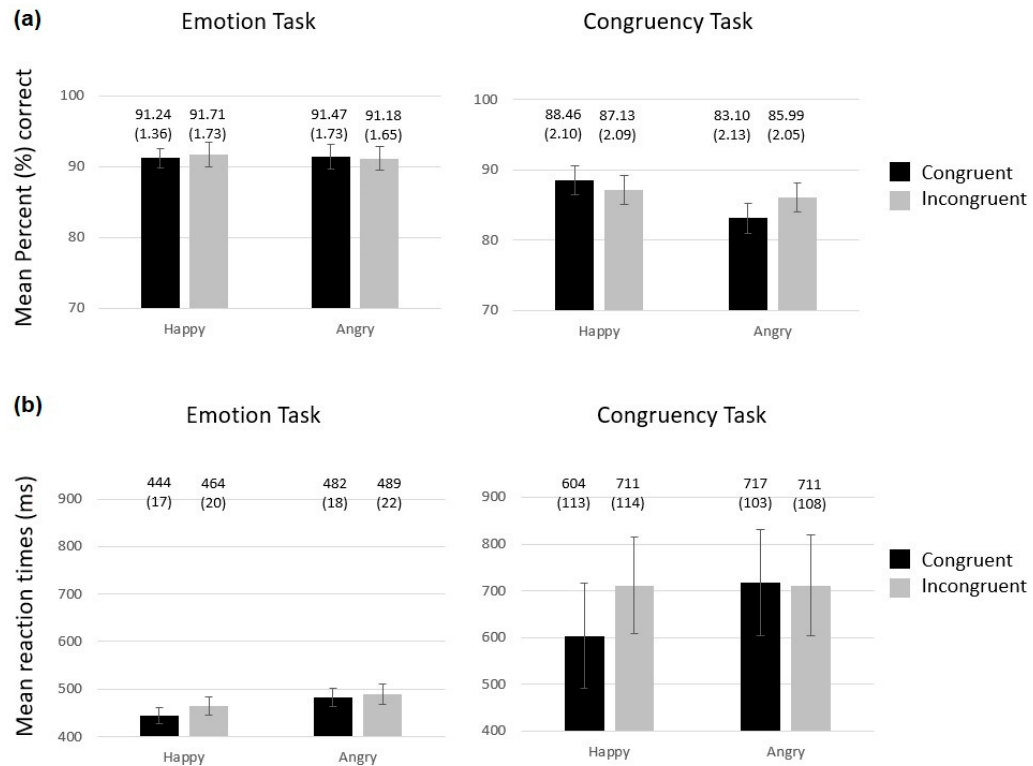
Figure 2. Percentage of correct responses ( a ) and mean response times ( b ) for each face emotion (happy or angry) and congruency of that emotion with the preceding sentence, for each task. Condition means (with standard error (SE) of the mean in parenthesis) are reported above each bar. A small e ff ect of congruency was found for angry faces in the congruency task for correct responses and an e ff ect of congruency was found on Response Times (RTs) for happy faces in the congruency task.